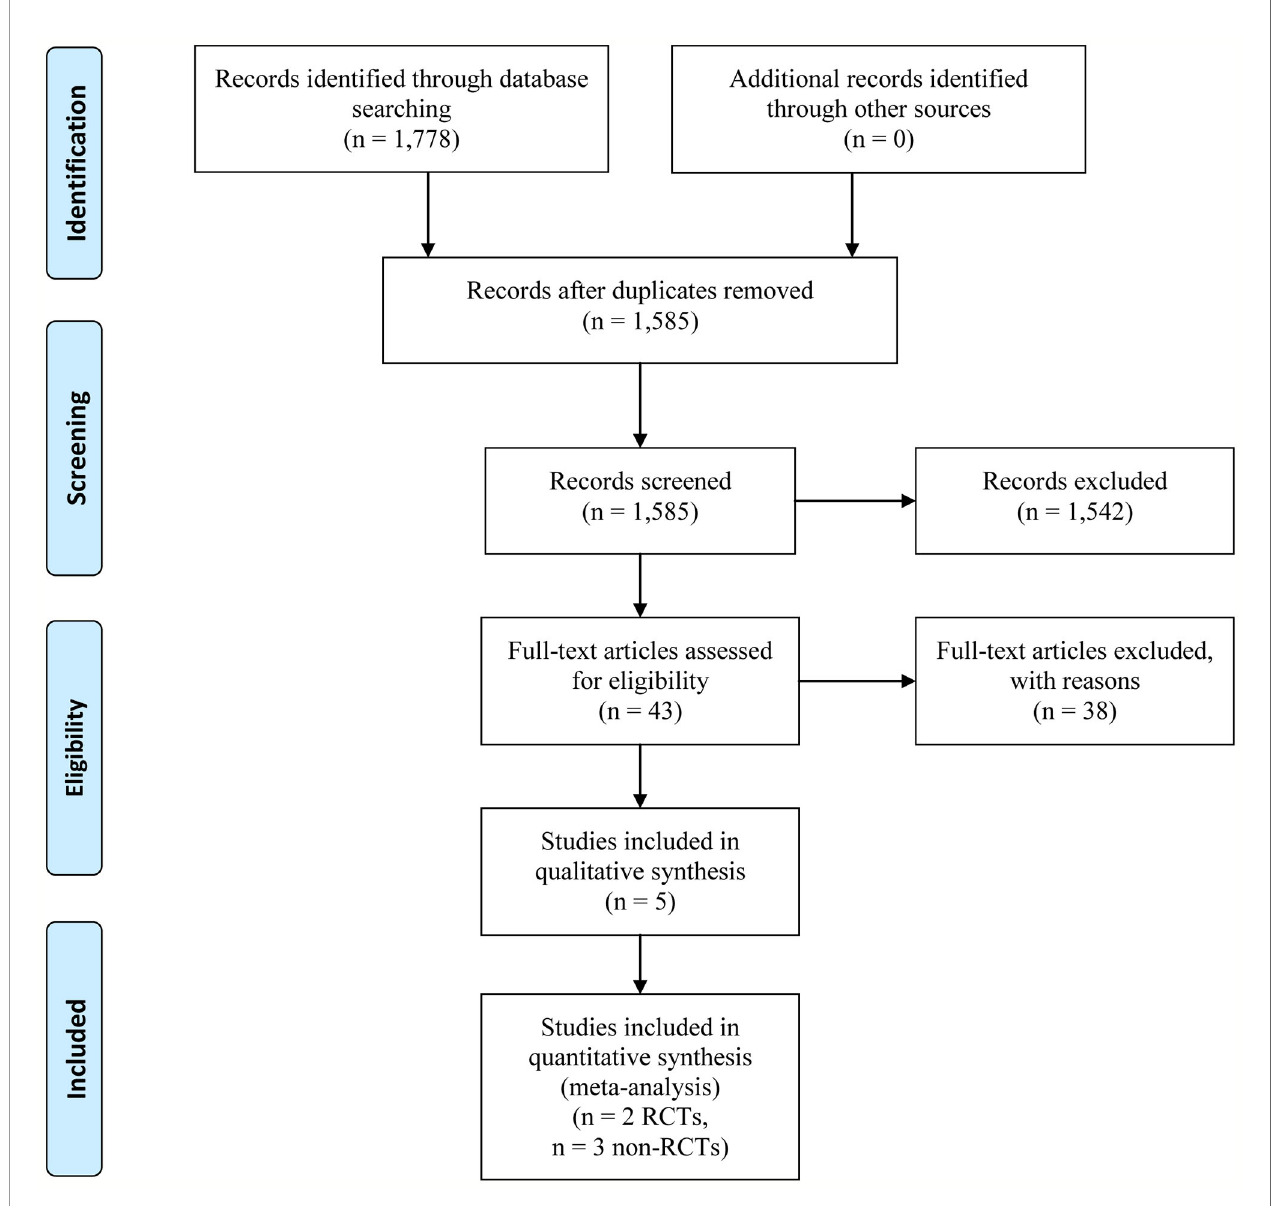
FIGURE 1 | Selection process of included